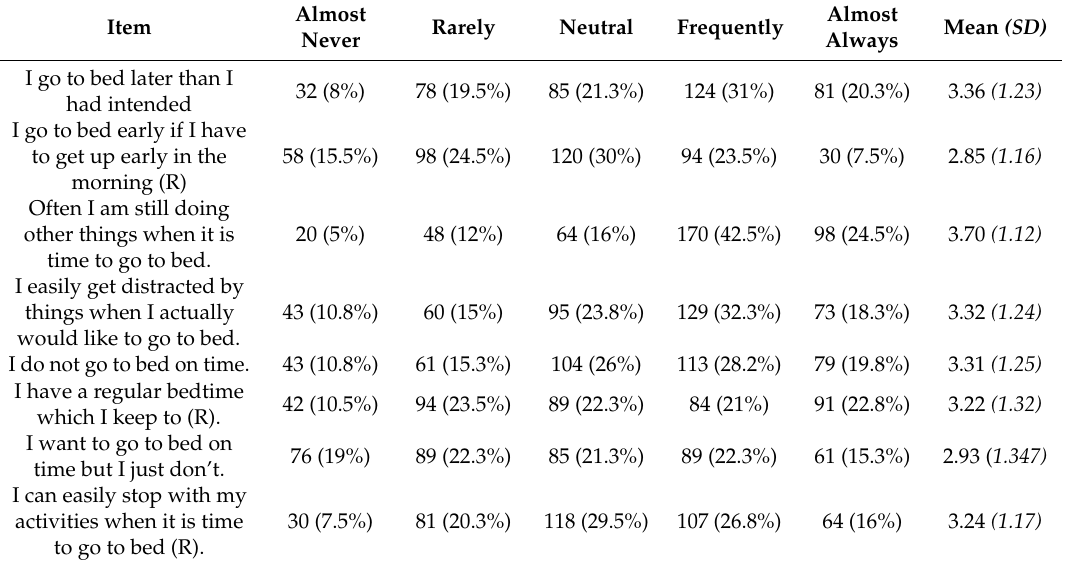
Table 1. Bedtime Procrastination Scale frequencies.